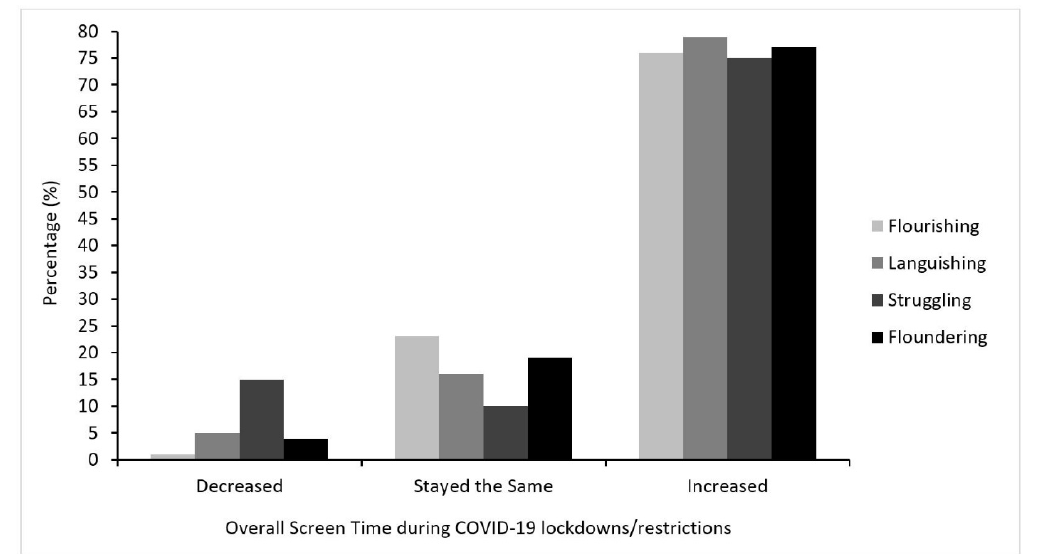
Figure 4. Changes in overall daily screen time during COVID-19 lockdowns/restrictions by mental health state. Table 4. Associations between screen time variables and mental health state during COVID-19 lockdowns/restrictions. Languishing vs. Struggling vs. Floundering vs. Variables Flourishing Flourishing Flourishing